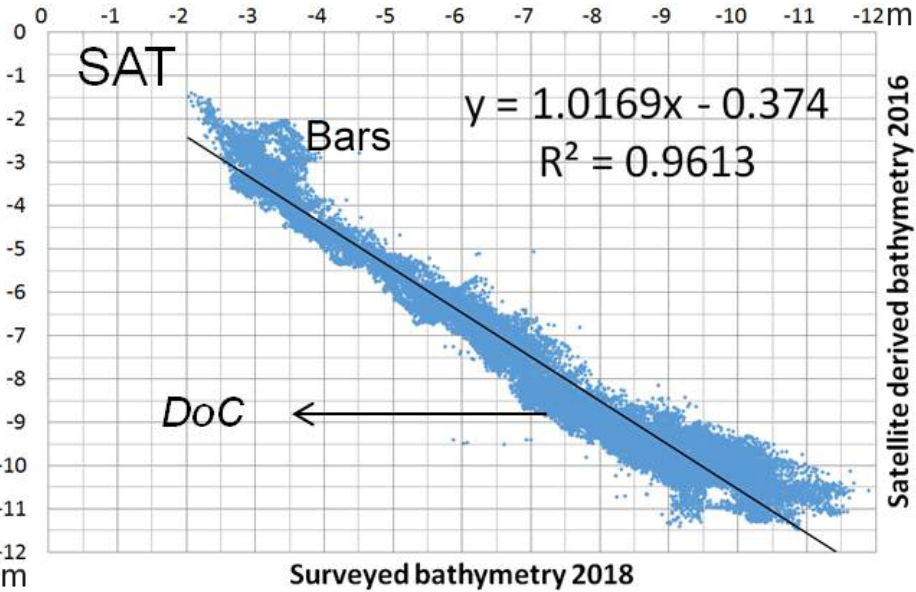
Figure 9. SDB with Stumpf’s model and real bathymetry plot.